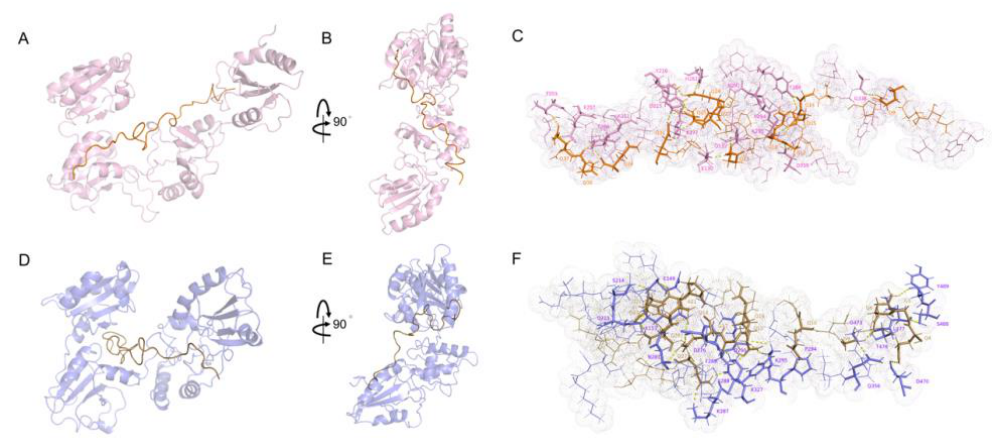
Figure 5. Interaction between WRS and wPDI O/R . ( A , B ) interaction between WRS and wPDI O cartoon representations of wPDI O (pink) and WRS (orange). ( C ) stick representations of amino acid residues involved in the interaction between wPDI O (pink) and WRS (orange). ( D , E ) interaction between WRS and wPDI R cartoon representations of wPDI R (slate) and WRS (sand). ( F ) stick representations of amino acid residues involved in the interaction between wPDI R (slate) and WRS (sand). Dotted amino acid residues are involved in the hydrophobic interactions and the dotted line indicates hydrogen bonds.